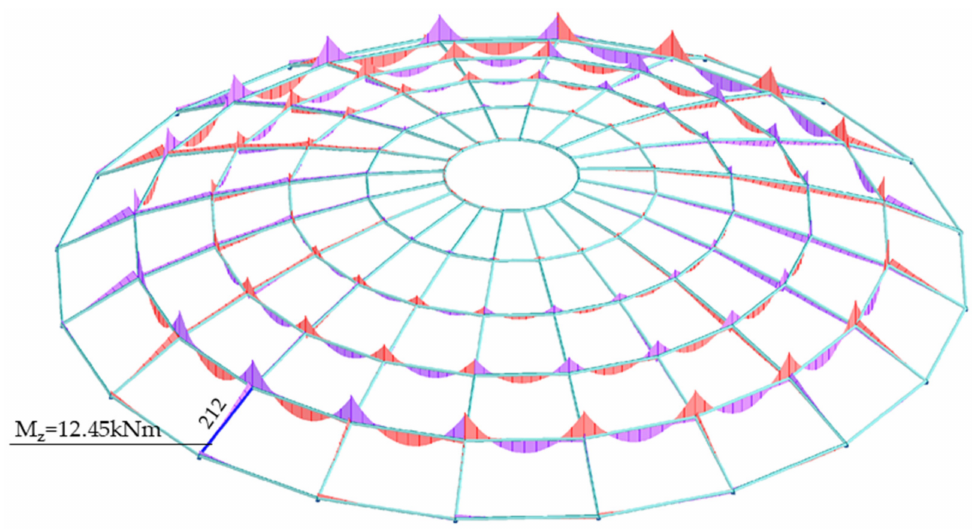
Figure 9. Bending moment with respect to the y-y axis My.